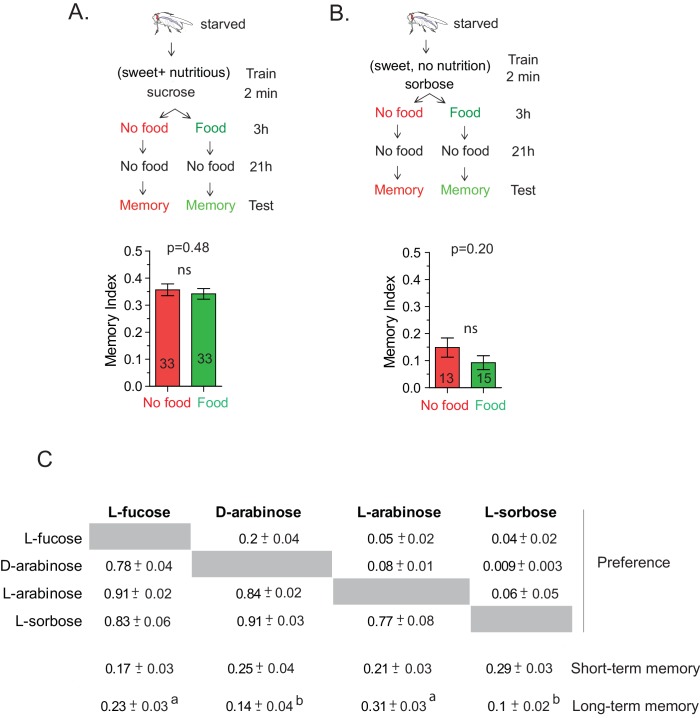
The CS-US association occurs during the two-minute training.(A) Flies trained with sucrose, which produces robust 24 hr memory, were immediately provided either rich nutritious food or water. If sucrose’s nutritional value is assessed beyond the 2-min training, nutritious food immediately after training may interfere with the fly’s ability to attribute its nutritional status to the 2-min training, and thus interfere with memory formation. However, flies trained with 1 M sucrose and given food or no food for 3 hr post-training showed similar memory, unpaired t-test, p=0.480. (B) Flies trained with L-sorbose—a sweet but non-nutritious sugar that produces short- but not long-term memory—were immediately fed sucrose. If the nutritional evaluation occurred after the 2-min training, immediate feeding on sucrose may substitute as a nutritional cue, resulting in enhanced long-term memory. However, flies trained with 1 M L-sorbose and given sucrose immediately after training showed similar memory to flies not given sucrose, suggesting that the critical association period was confined to the 2-min training, unpaired t-test, p=0.207. (C) Matrix of flies’ preference for one sugar (top) when paired side-by-side with another sugar (side) for 5 min. Each comparison was tested with four independent trials, 50 flies per trial. Numbers are the proportion eating the sugar listed at top. (Proportions may not sum to 1.0; often several flies would not eat either sugar.) Short-term memory and long-term memory averages shown below with ± s.e.m. Memory scores labeled a are significantly different (p<0.05) from bars labeled b, analyzed by one-way ANOVA with Tukey’s multiple comparisons test.